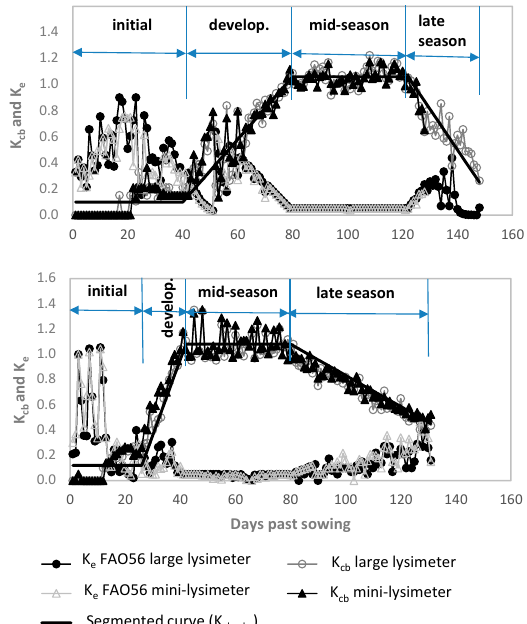
Figure 8. Dual crop coefficient for sprinkler-irrigated barley (top graph) and potato (bottom graph). K e values were estimated using the FAO56 approach and the basal crop coefficient, K cb , was calcu- lated from large and mini-lysimeter K c minus calculated K e . The FAO56 segmented K cb curve was fitted with the identification of the four general crop growth stages.